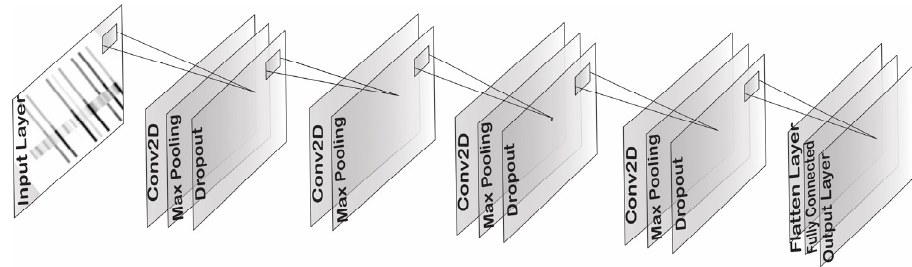
Figure 4. Proposed model architecture with 1 input layer, 4 convolutional layers and 1 output layer.